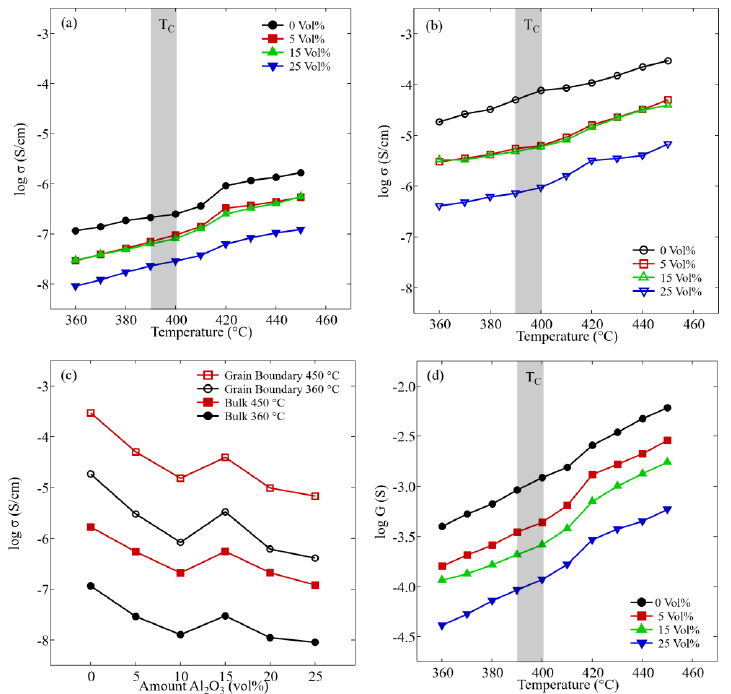
Figure 4. Conductivity of NKN as a function of temperature for bulk ( a ) and grain boundary ( b ), together with the overall conductance G ( d ) at selected vol% Al 2 O 3 . Gray area shows the phase transition region, which was estimated from permittivity–temperature data. Furthermore, bulk and grain boundary conductivities at 360 ◦ C and 450 ◦ C are shown as a function of Al 2 O 3 content ( c ).